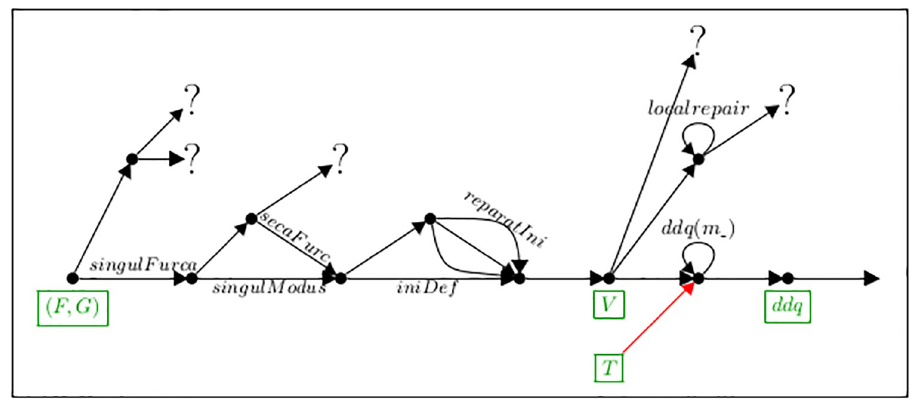
Fig 20. Described transformation